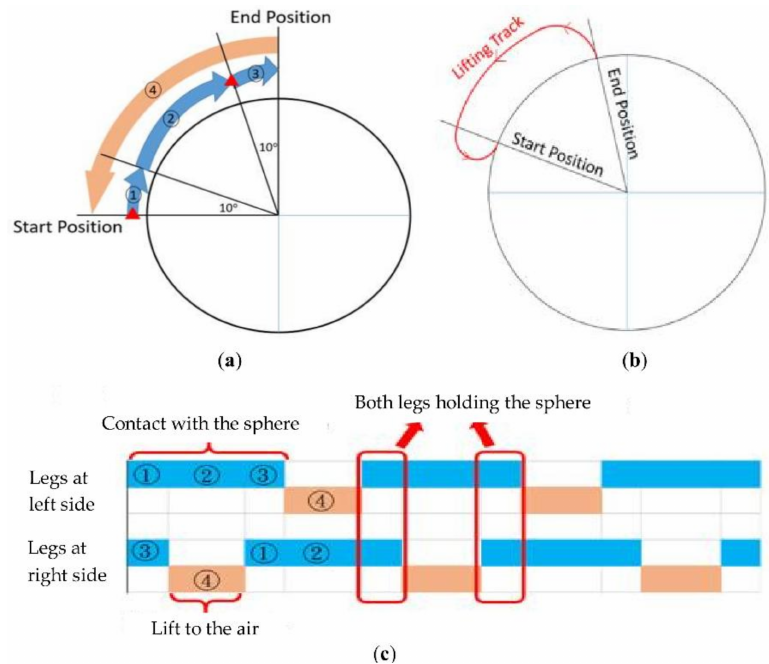
Figure 9. Trajectory planning of the robot legs: ( a ) the leg trajectory on the ball has four stages. Red triangles show where both legs are initially placed; ( b ) the side view of the leg trajectory; and ( c ) the timing diagram of a pair of either mid- or